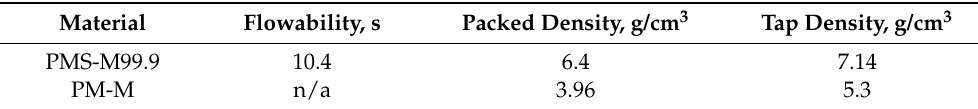
Table 2. The chemical composition of the Mo powders PMS-M99.9 and PM-M. Elements Composition, % Mass Material Mo Residual Elements 1 , Total O Material PMS-M99.9 Balance PM-M Balance